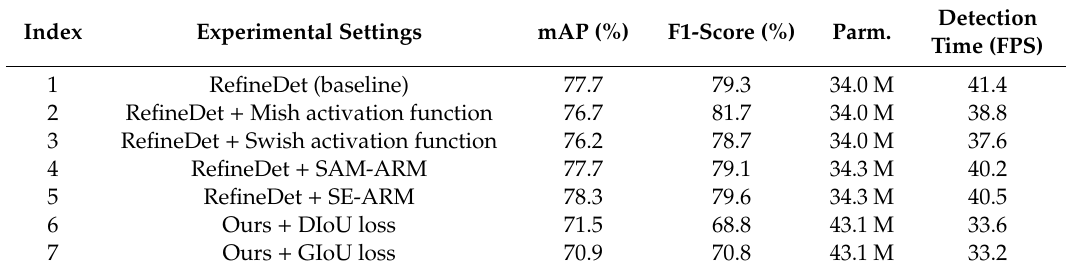
Figure 15. Detection results with different Tmax of Cosine annealing scheduler. Table 5. Performance of different other optimization methods